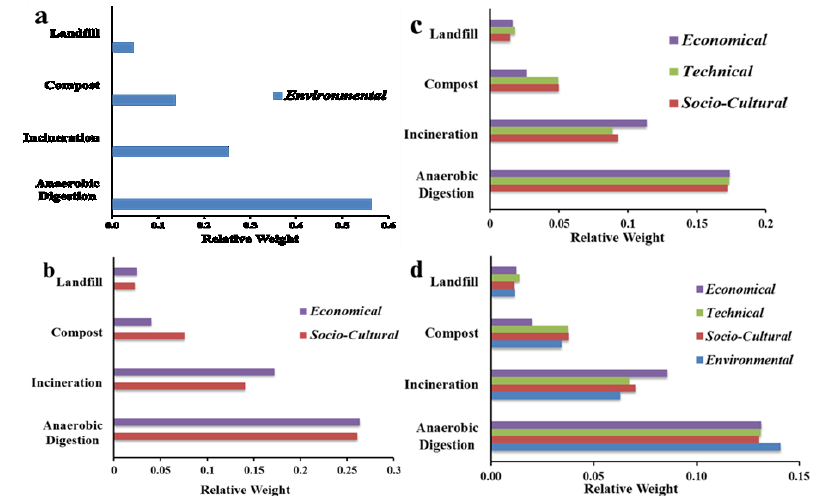
Figure 3. Sensitivity analysis: ( a ) one of the criteria has a relative weight of 1 while the others are at 0, ( b ) two criteria have a relative weight of 0.5 each while others are at